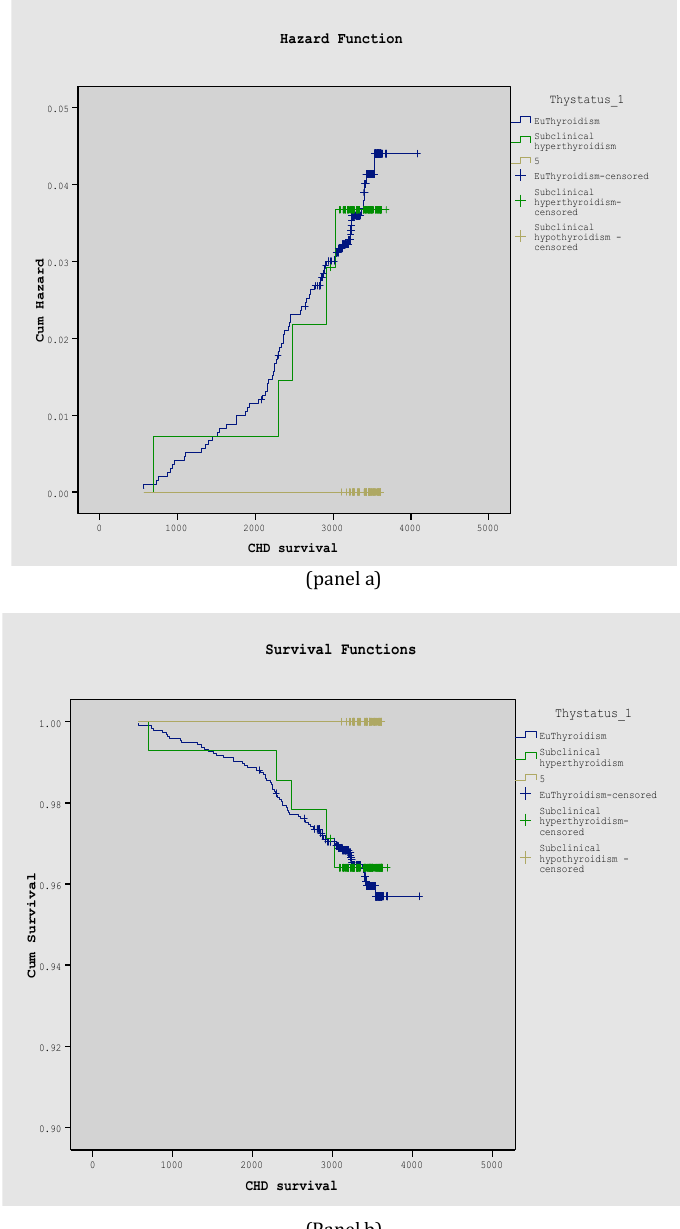
(Panel b) Figure 1. (panel a): Kaplan Meier of cumulative hazard of CHD for subjects with subclinical hyperthyroidism versus subjects with euthyroidism, in subclinical hypothyroidism we had no events (Panel b): Kaplan- Meier cumulative survival of CHD for patients with subclinical hyperthyroidism versus subjects with euthyroidism,in subclinical Hypothyroidism we had no CHD